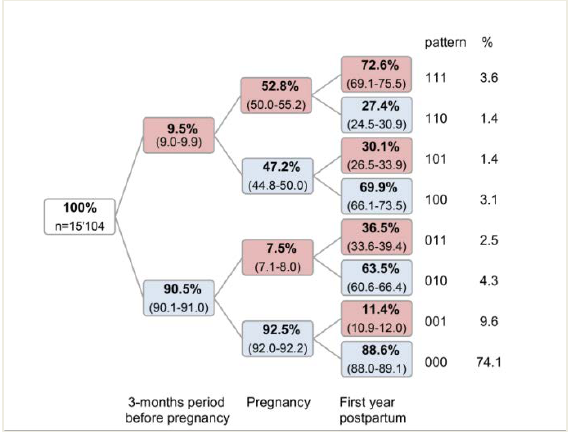
Figure 1: Trajectories of the use of mental healthcare for perinatal women in Switzerland, expressed as conditional percentages of women using mental health services (%) in consecutive periods. Red box or code 1: use of mental health services, blue box or code 0: no use of mental health services. The period patterns indicate three consecutive periods from left to right, e.g., the pattern 001 indicates use of mental health service postpartum, but not before pregnancy or during pregnancy. Helsana health insurance